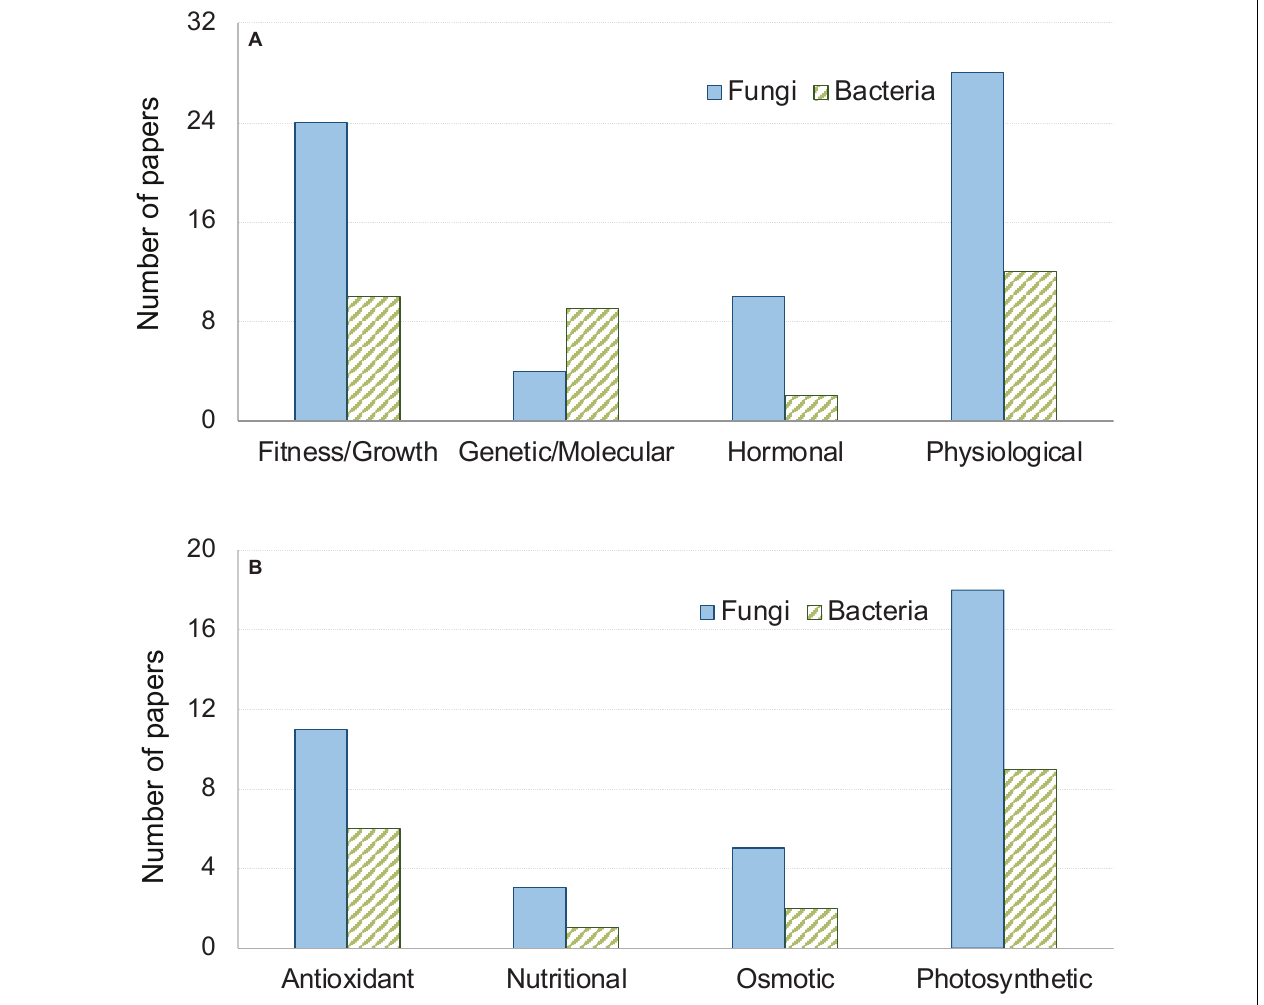
FIGURE 1 | Number of papers out of the total 42 papers reviewed here grouped by response variables. Broad categories of variable are shown in panel (A) , while physiological responses are shown in panel (B) .